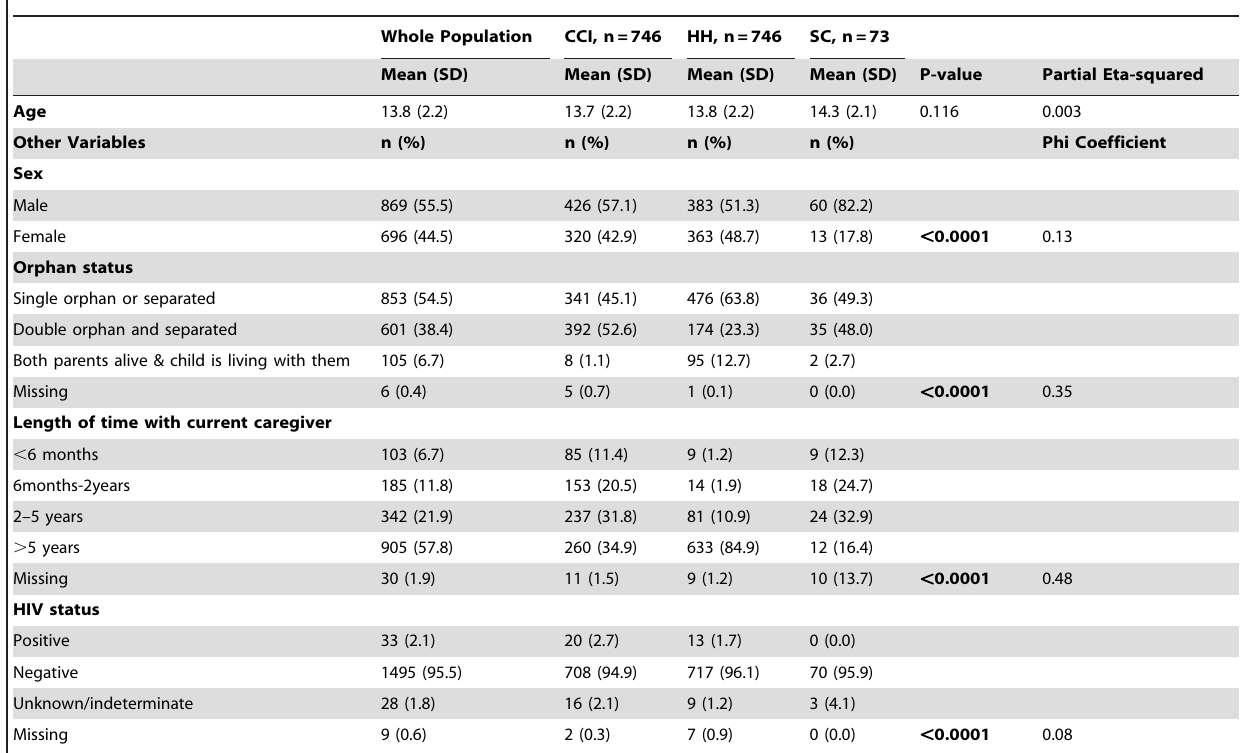
Table 1. Socio-demographic characteristics N=